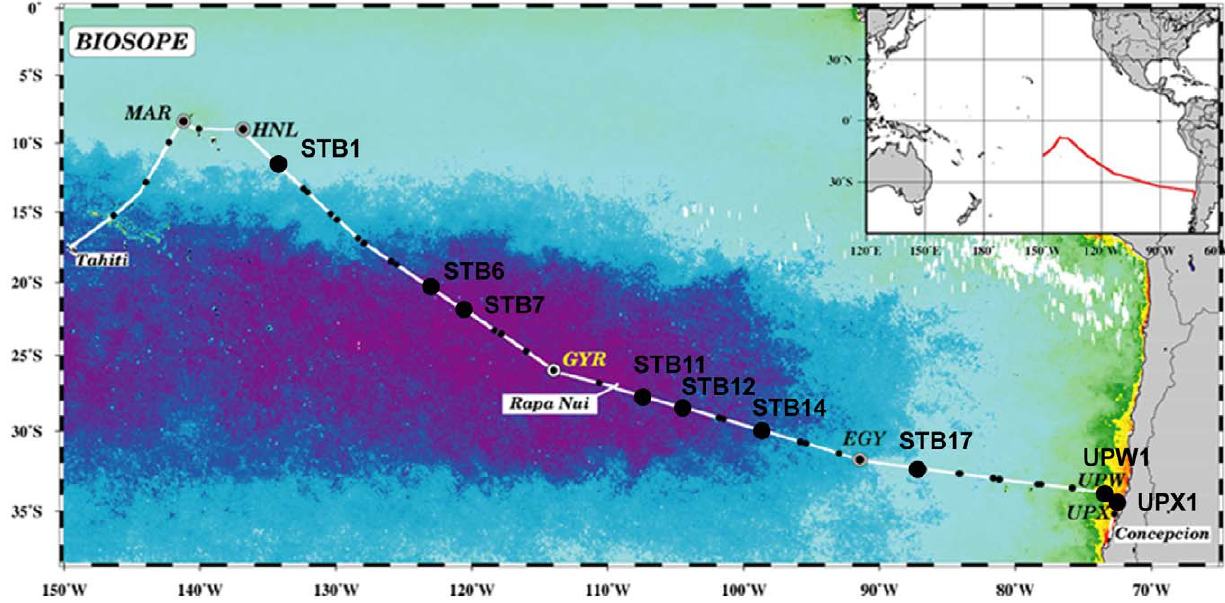
Figure 1. Map of stations sampled in the South East Pacific Ocean during the BIOSOPE cruise (2004). BIOSOPE cruise track map superimposed on a SeaWiFS ocean colour composite, the dark purple indicating extremely low values (0.018 mg m 2 3 ) of total chlorophyll a . Black dots indicate the stations analysed by 16S rRNA gene clone libraries.